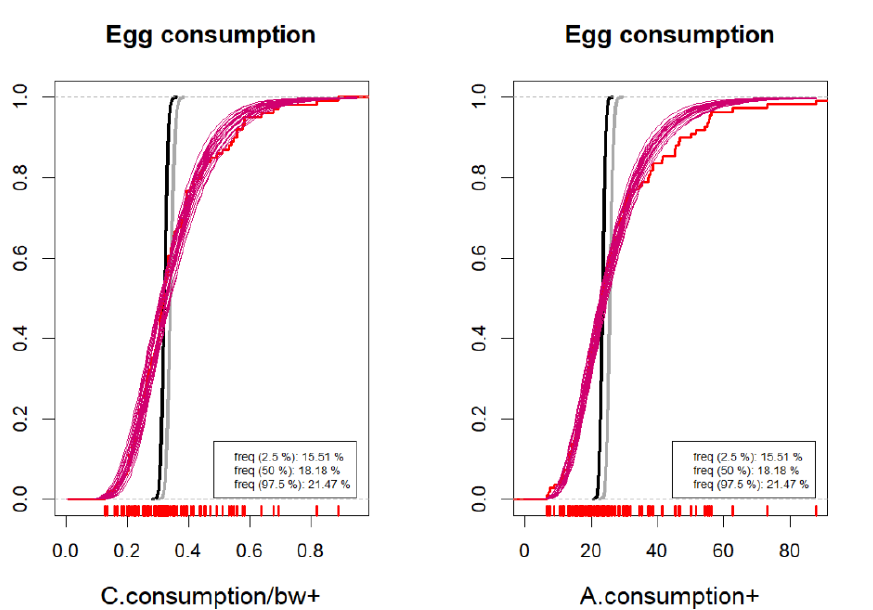
Figure 3. Example cumulative distributions of consumption on actual consumption days in the pop- ulation of consumers. Chronic consumption per body weight ( left ) and acute absolute consumption ( right ). A sample of probable consumption distributions (magenta), and the uncertainty distributions for consumption mean (gray) and median (black). Observed data empirical cumulative distribution in red with data points shown as red ticks. Estimated frequency of consumption days is given numerically. Numerical values on horizontal axis depend on the measurement unit used in the user’s data, e.g., g, kg or ml etc.